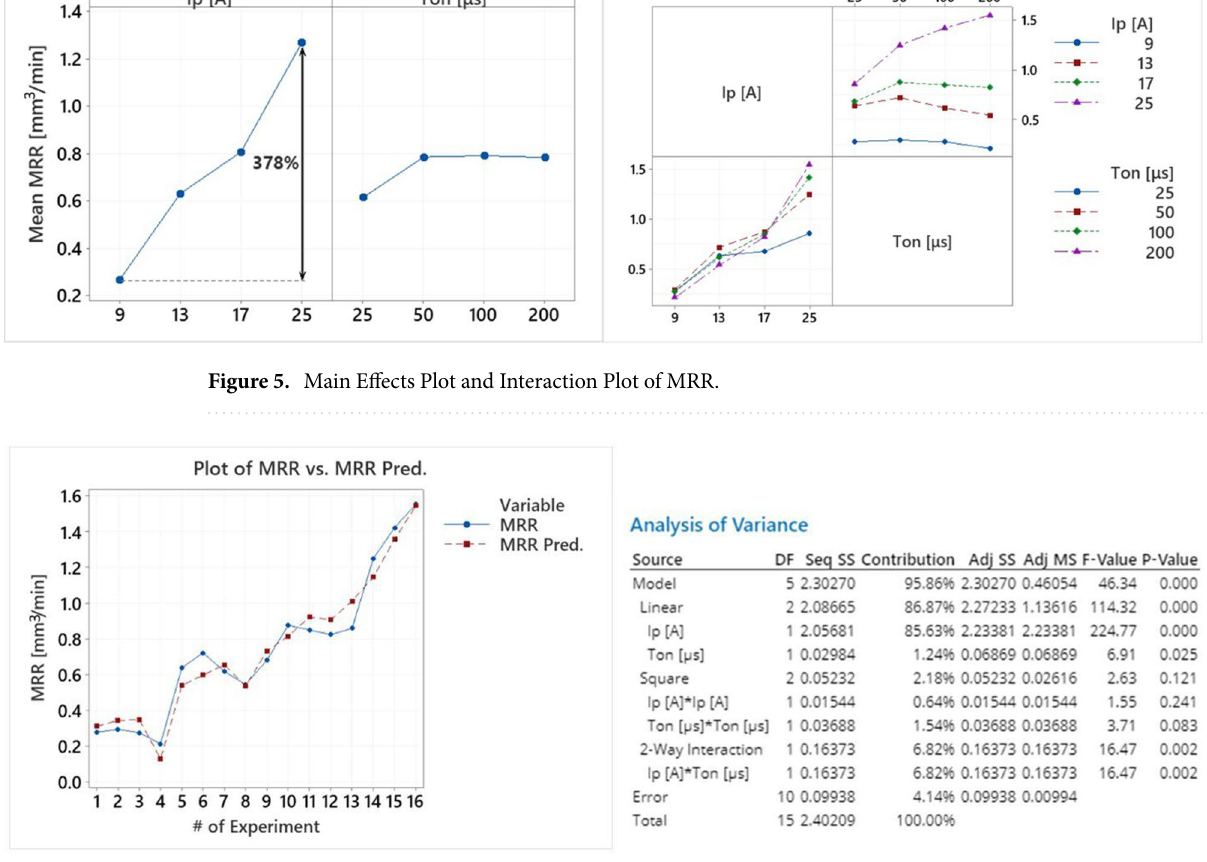
Figure 6. Plot of MRR vs MRR predicted and the model’s